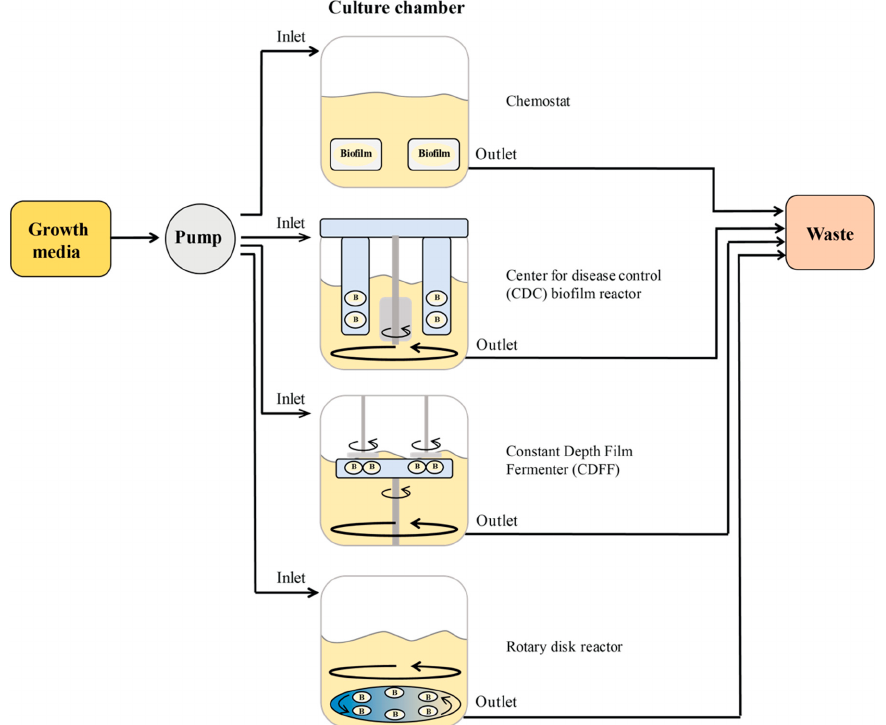
Figure 6. General schematics of the components of biofilm reactors.